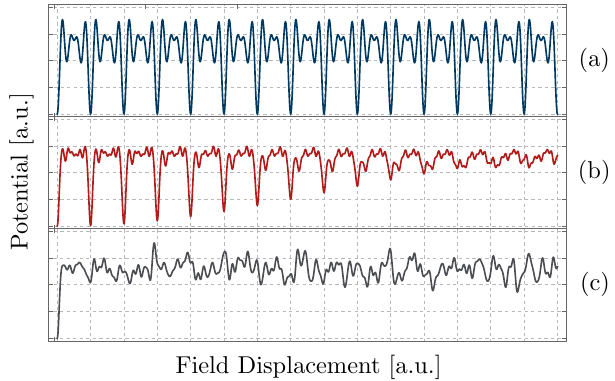
Figure 4 . The potential plotted along three di(cid:11)erent rays through (cid:12)eld space (starting at the global minimum), for an example of the potential in (1.1) with N = 23 ; P = 40. Top pane : a line oriented along an exact symmetry direction. Middle pane : a line oriented along an approximate symmetry direction. Bottom pane : a random